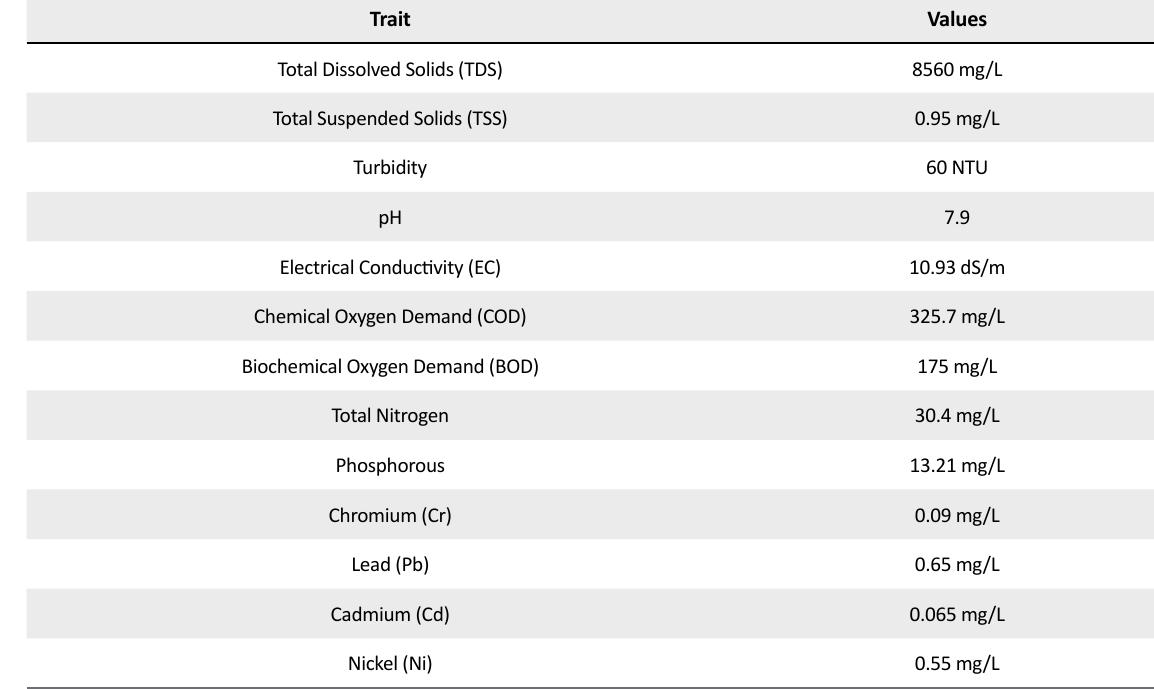
Table 1. Some important properties of the municipal sewage influent